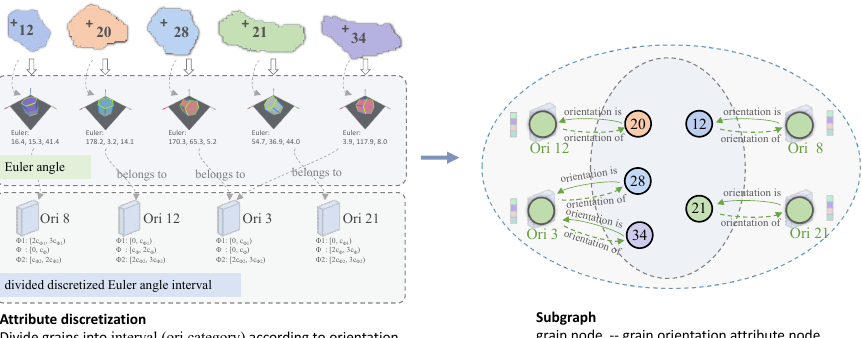
Figure 7. Grain-orientation edge construction. First, the grains are classified into corresponding orientation categories, and then, the corresponding orientation category nodes (orientation attribute nodes) are connected to the grain nodes. In this way, the grain node and the orientation attribute node constitute a subordination relationship.